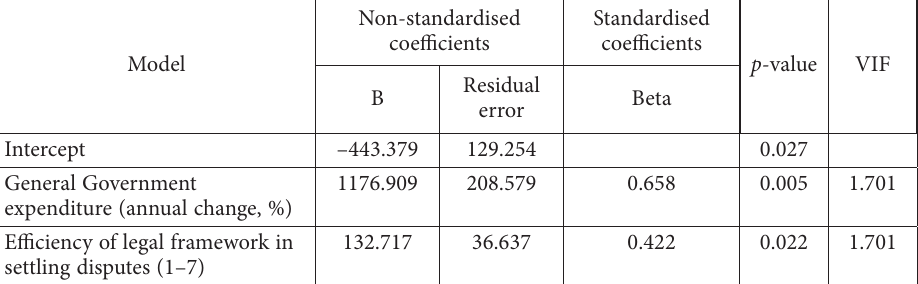
Table 5. Coefficients of the multiple linear regression equation, p -value, and VIF factor (source: authors)